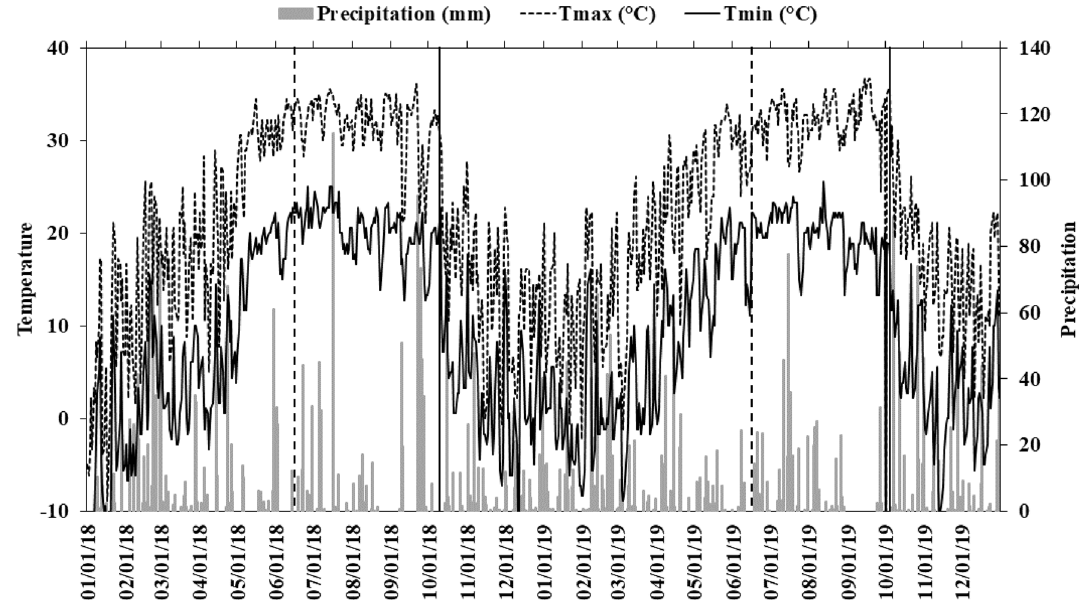
Figure 2. Daily maximum and minimum air temperature and precipitation during 2018 and 2019. Tmax, maximum air temperature; Tmin, minimum air temperature. The vertical dashed lines represents the shelter establishment dates and the vertical solid lines represent the shelter removal dates during 2018 and 2019.